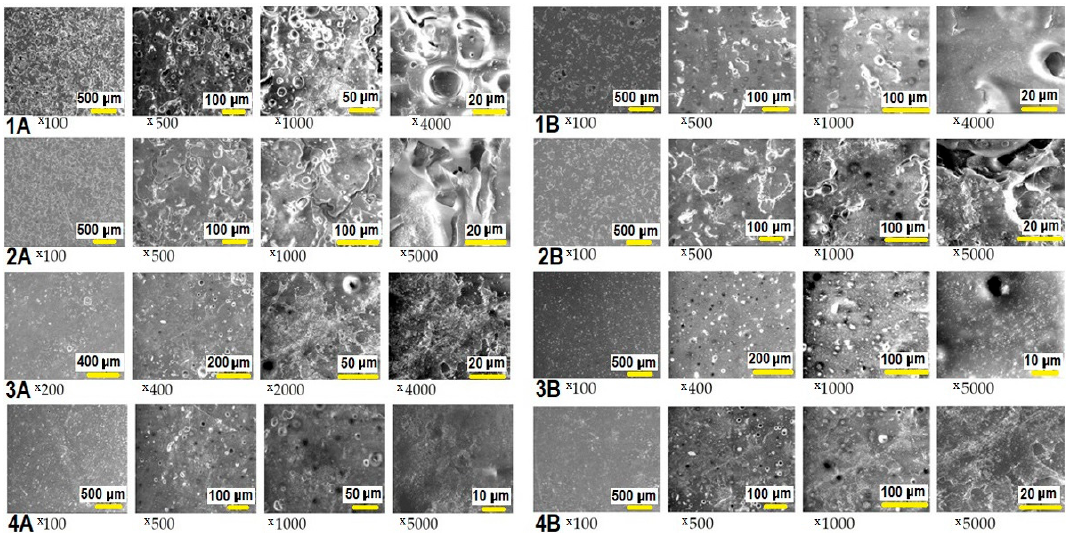
Figure 6. SEM micrographs of the FRC samples after extraction and gentamicin release.